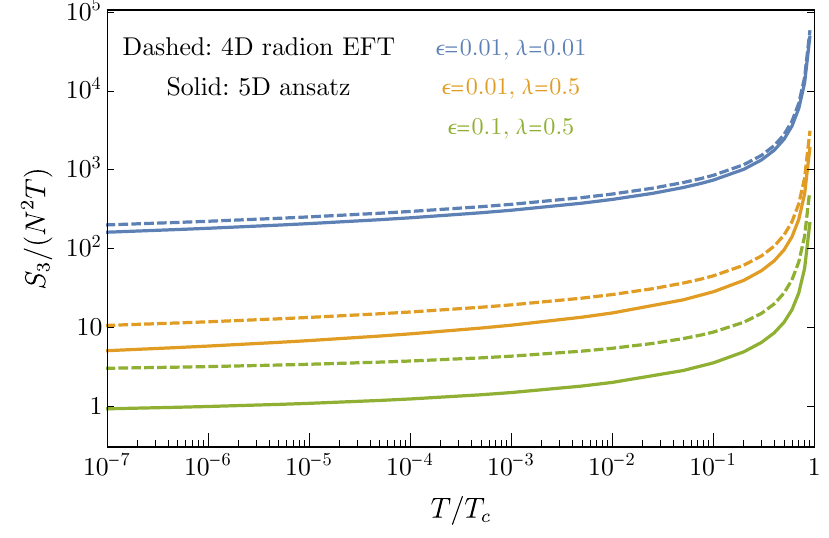
p 16 π 2 M 3 , as a function of 5